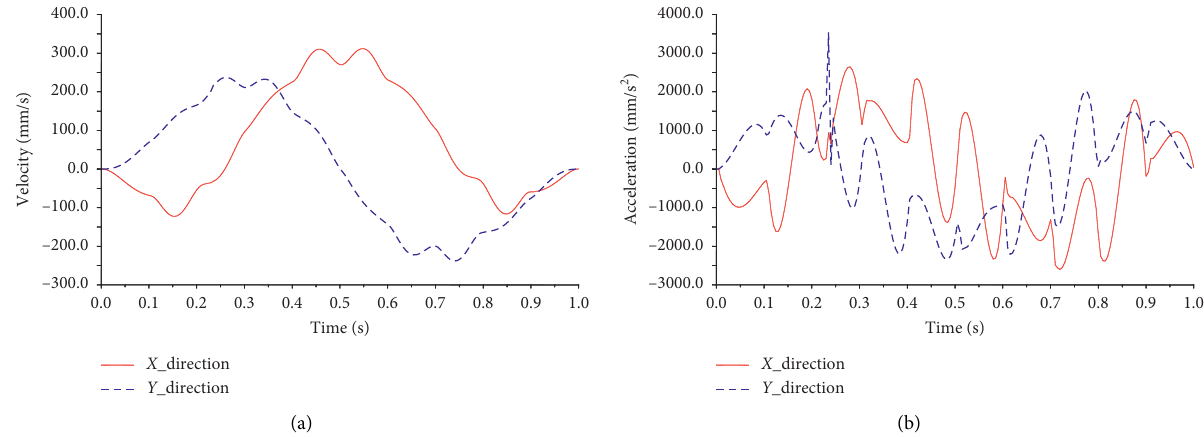
Figure 16: Foot-end motion characteristics of virtual prototype. (a) Foot-end speed curve. (b) Foot-end acceleration curve.